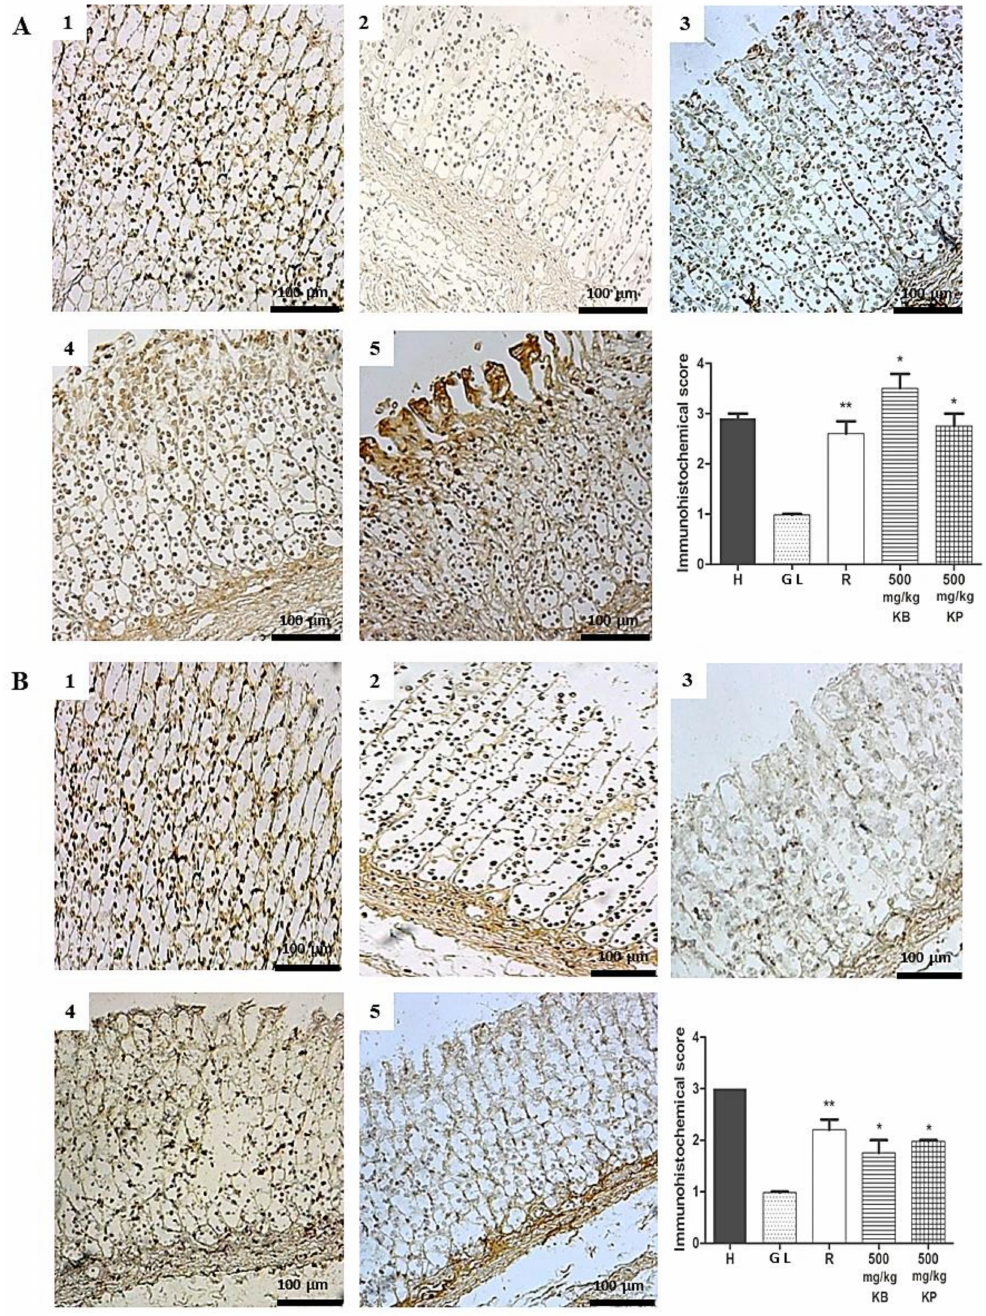
Figure 11. Immunohistochemical analysis of ZO-1 expression in the gastric mucosa in ethanol-induced and indomethacin-induced gastric lesions in rats. Immunohistochemical analysis of ZO-1 expression in rat gastric tissue, showing the cut of the stomach in the longitudinal direction. ( A ) Ethanol-induced: (1) Healthy; (2) Gastric lesion control; (3) Ranitidine 50 mg/kg; (4) K. brasiliensis 500 mg/kg; (5) K. pinnata 500 mg/kg. ( B ) Indomethacin-induced: (1) Healthy; (2) Gastric lesion control; (3) Ranitidine 50 mg/kg; (4) K. brasiliensis 500 mg/kg; (5) K. pinnata 500 mg/kg. Data expressed as mean ± standard mean error, ( n = 5). Mann–Whitney used to calculate statistical significance, * p <0.05 and ** p < 0.01 vs. gastric lesion control. Healthy, H; Gastric lesion control, GL; Ranitidine, R. K. brasiliensis , KB; K. pinnata ,